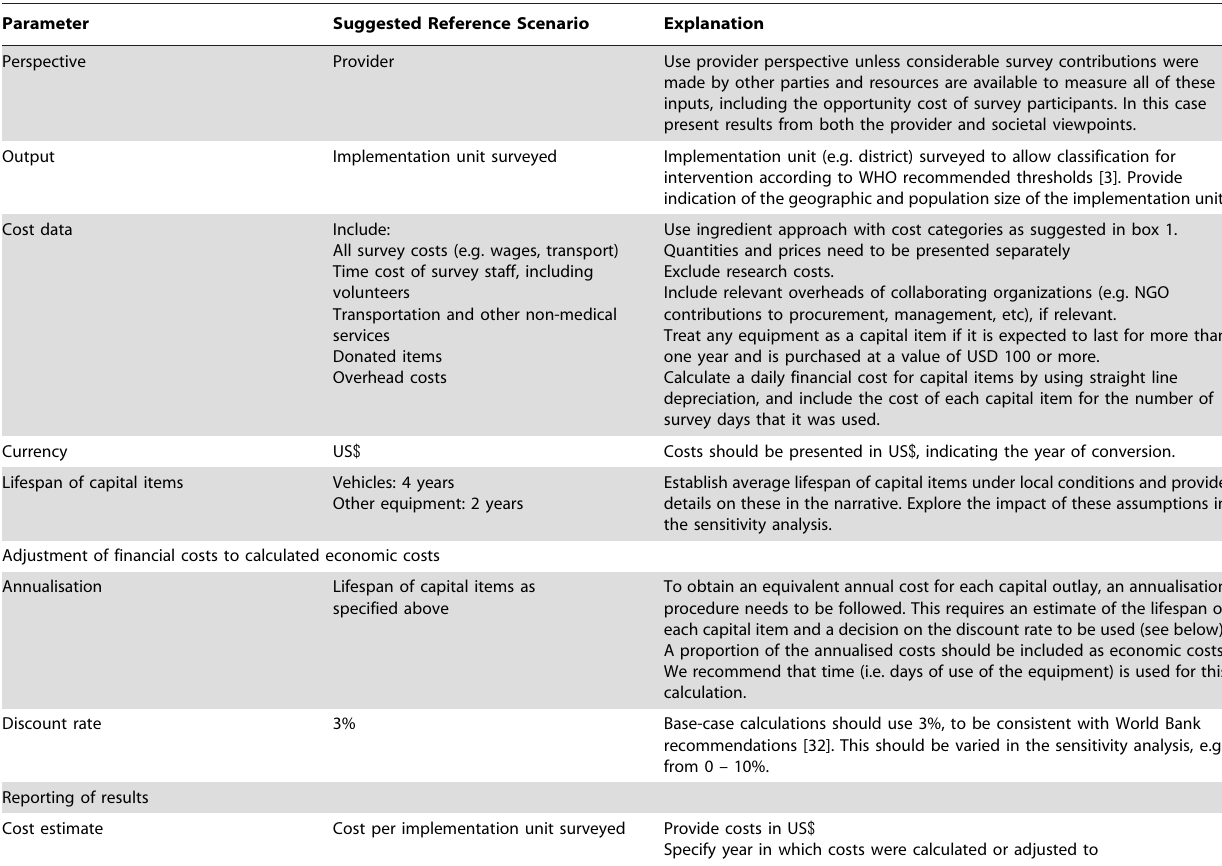
Table 1. Reference case